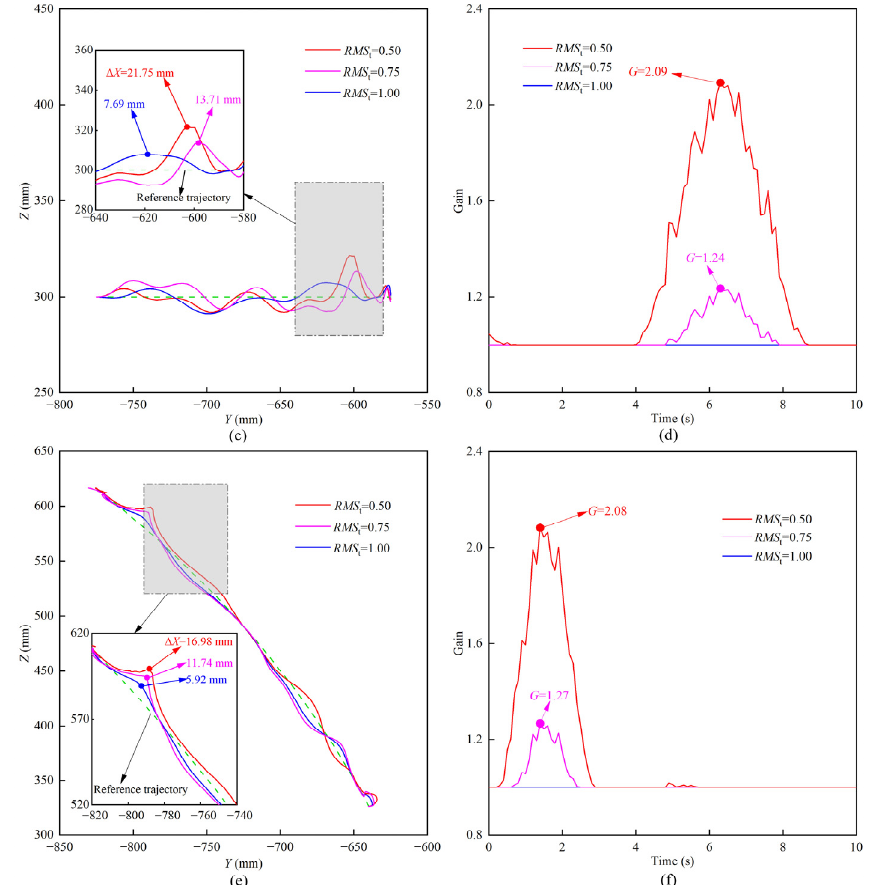
Figure 15. EGCC experimental results of HE-LRR. ( a ) Actual trajectories in the MOTOmed training mode; ( b ) gain parameters in the MOTOmed training mode; ( c ) actual trajectories in the CPM training mode; ( d ) gain parameters in the CPM training mode; ( e ) actual trajectories in the SLR training mode; ( f ) gain parameters in the SLR training mode.